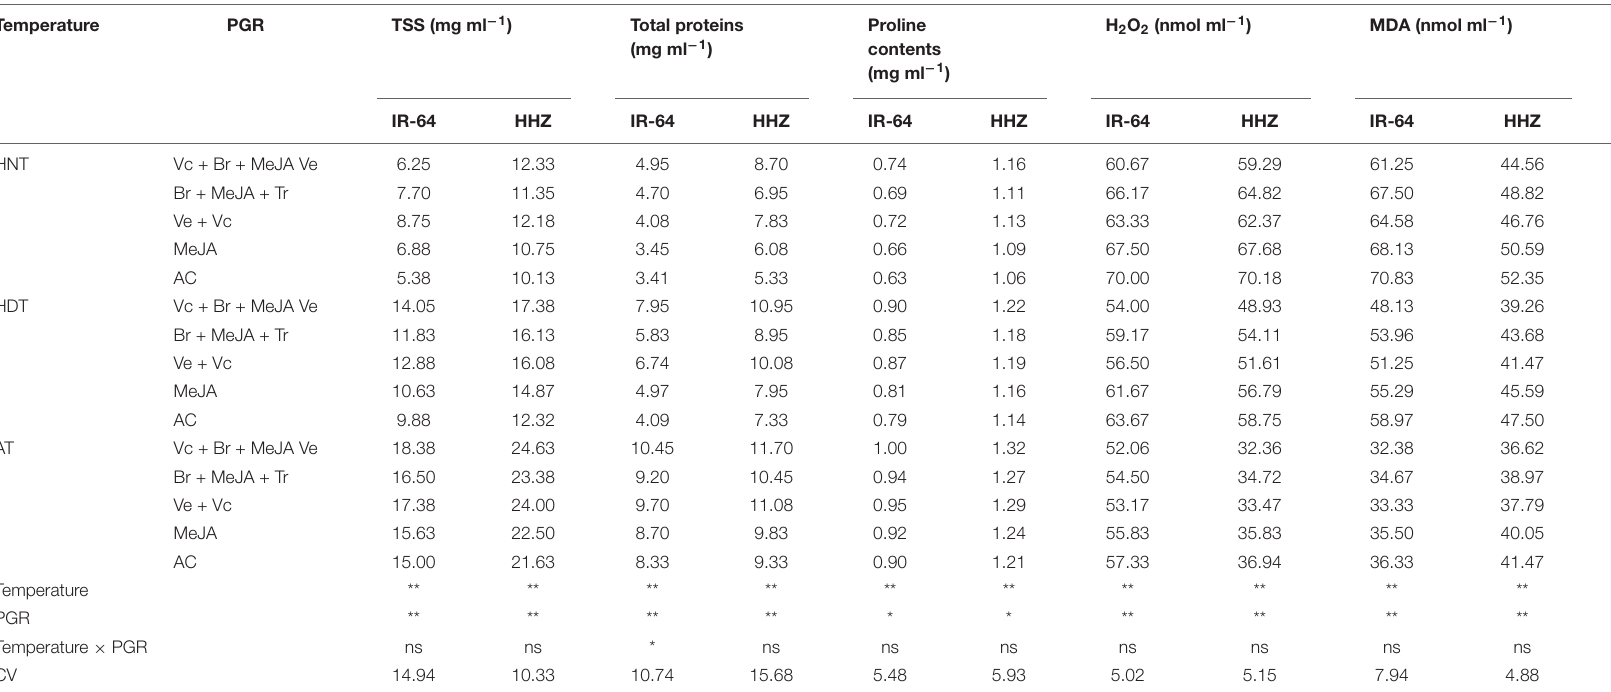
TABLE 2 | Total soluble sugars (TSS), proteins, proline, H 2 O 2 , and MDA accumulation in xylem sap of two rice cultivar as affected by plant growth regulators under heat stress at heading.